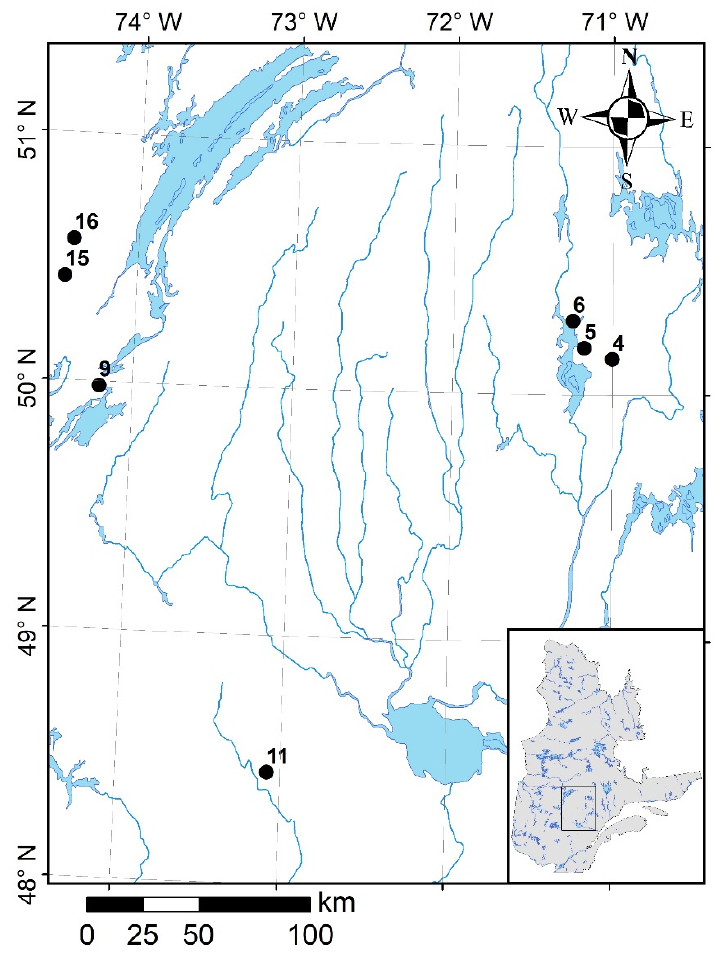
Figure 1. Location of the seven study sites in the province of Quebec, Canada. Regional climate is cool continental with a mean daily temperature of 0.2 ◦ C, which varies from − 18.8 ◦ C in January to 16.4 ◦ C in July and an annual precipitation of 995.8 mm, of which 312.9 mm (31%) occurs as snowfall (climate normals from 1981 to 2010, Environ- ment Canada, Chapais 2 station, 49 ◦ 47 (cid:48) N, 74 ◦ 51 (cid:48)